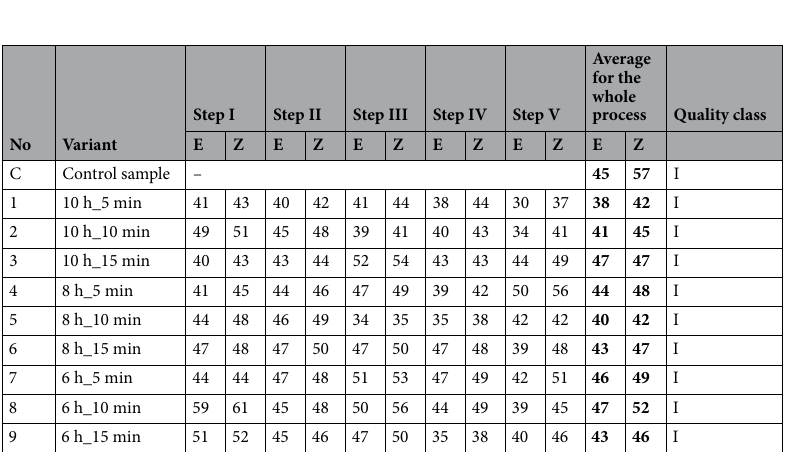
Table 9. Germination energy and capacity for the control seeds as well as for seeds obtained from the various extraction process variants. E – energy, Z – germination capacity. Significant values are in bold.